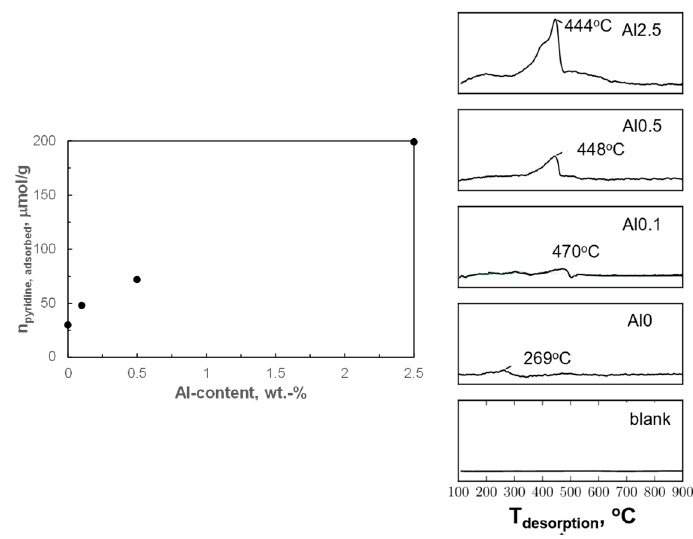
Figure 5. Uptake (left) and temperature programmed desorption (right) of pyridine from the reduced samples (reduction in pure H 2 , 300 ml n /g/min; T reduction = 350 °C; t reduction = 0.5 h).